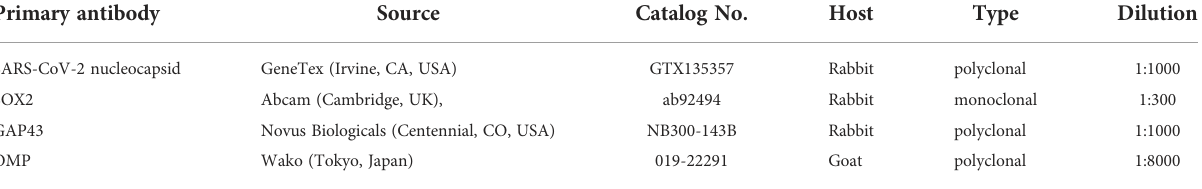
TABLE 1 Primary antibodies used in this study. Primary antibody Source Catalog No.